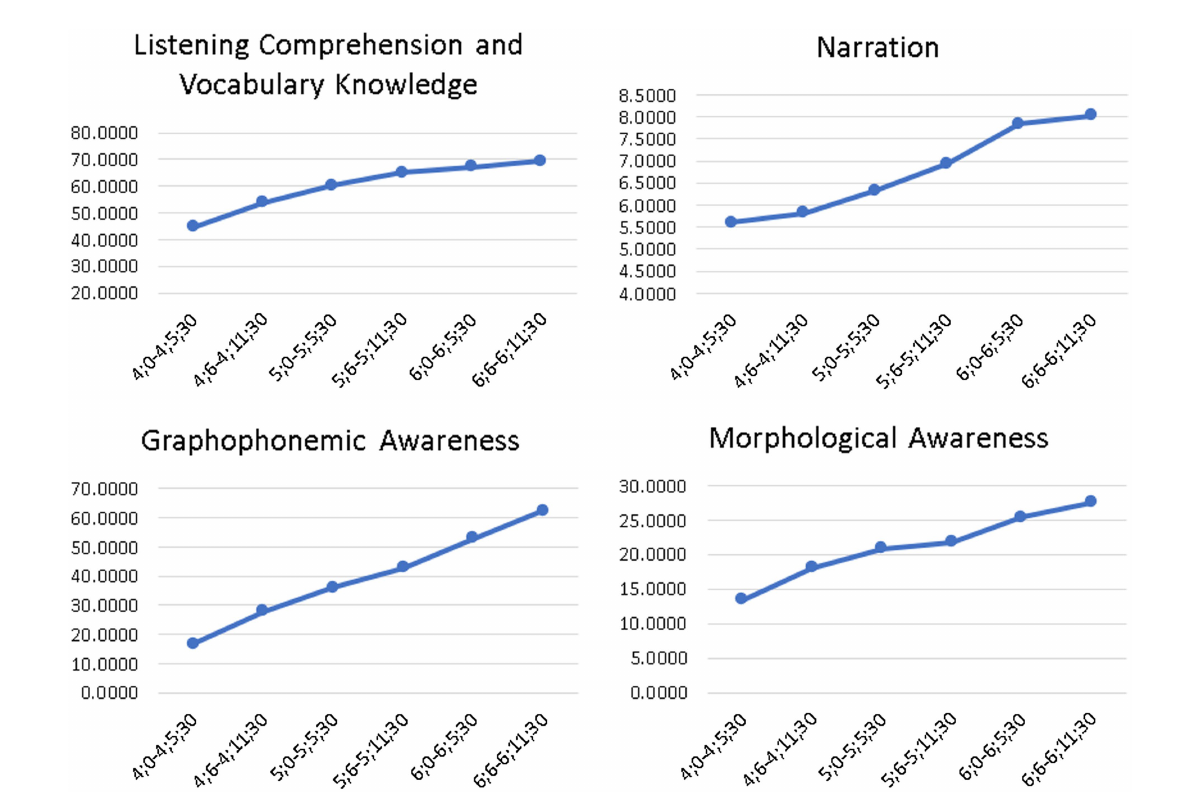
FIGURE 2 Developmental trajectories of the four domains of the Logometro for the different age groups.